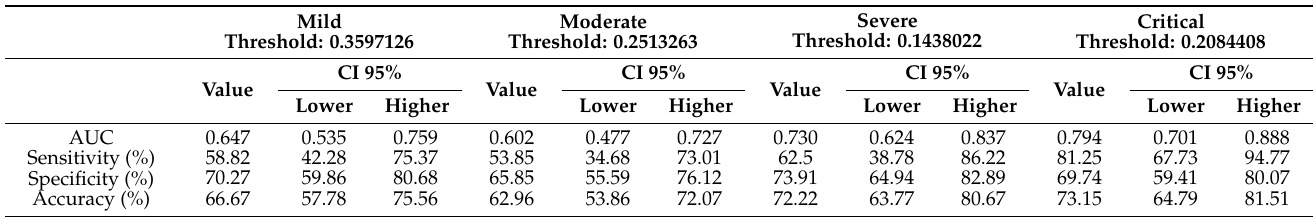
Table 4. Internal validation in each degree of severity using the AUC (area under the ROC curve). Severe Mild Moderate Threshold: Threshold: 0.3597126 Threshold: 0.2513263